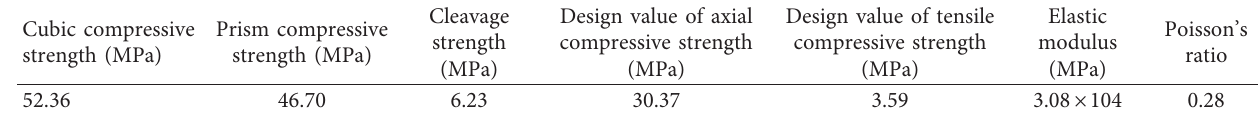
Table 5: Mechanical properties of geopolymer